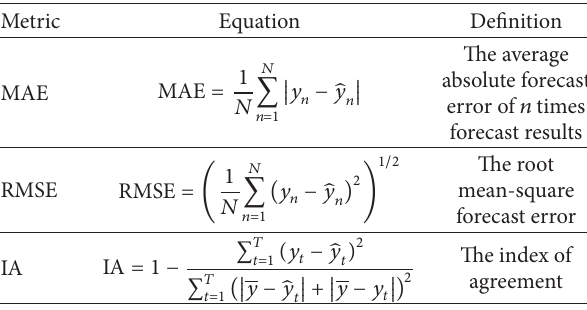
Table 1: Four evaluation